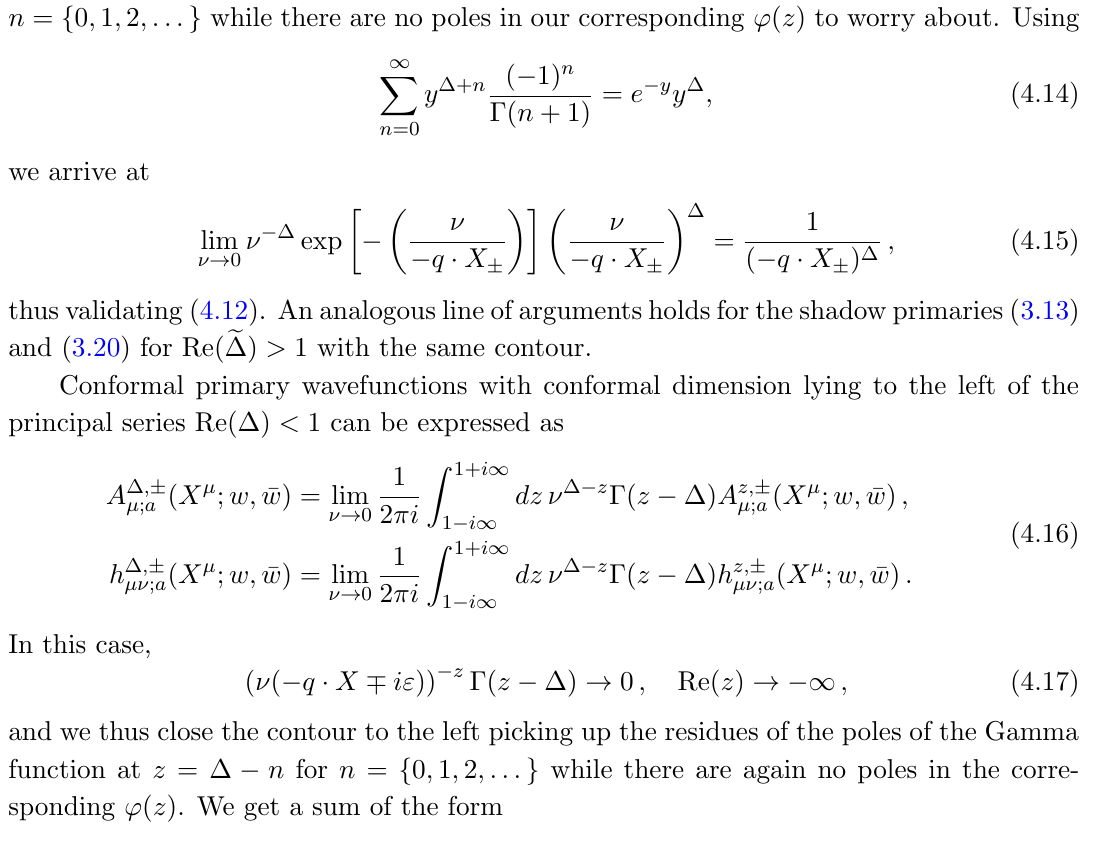
Figure 2. Conformal primaries with general conformal dimension (cid:1) can be expressed as integrals along the principal series contour z = 1 + i(cid:21) with (cid:21) 2 R . Depending on whether Re((cid:1)) ? 1 the contour is deformed to the right (2a) or left (2b). For illustration we have drawn the pole positions corresponding to (cid:1) = 2 and (cid:1) = 0 in (2a) and (2b), respectively. Using (3.13) and (3.20), we see the same contours are relevant for the shadow modes with ~(cid:1) = 2 and ~(cid:1) = 0, respectively. Applying the results of section 4.1 we close the contour to the right of the principal contin- uous series, picking up the residues of the poles of the Gamma function at z = (cid:1) + n